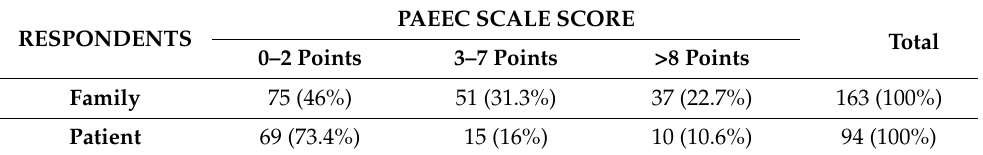
Table 3. Distribution of health-related quality of life according to questionnaire